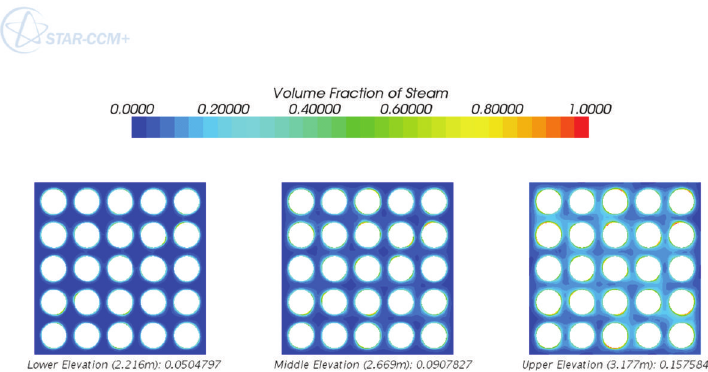
Figure 9: Void distributions in the 3 measuring planes.